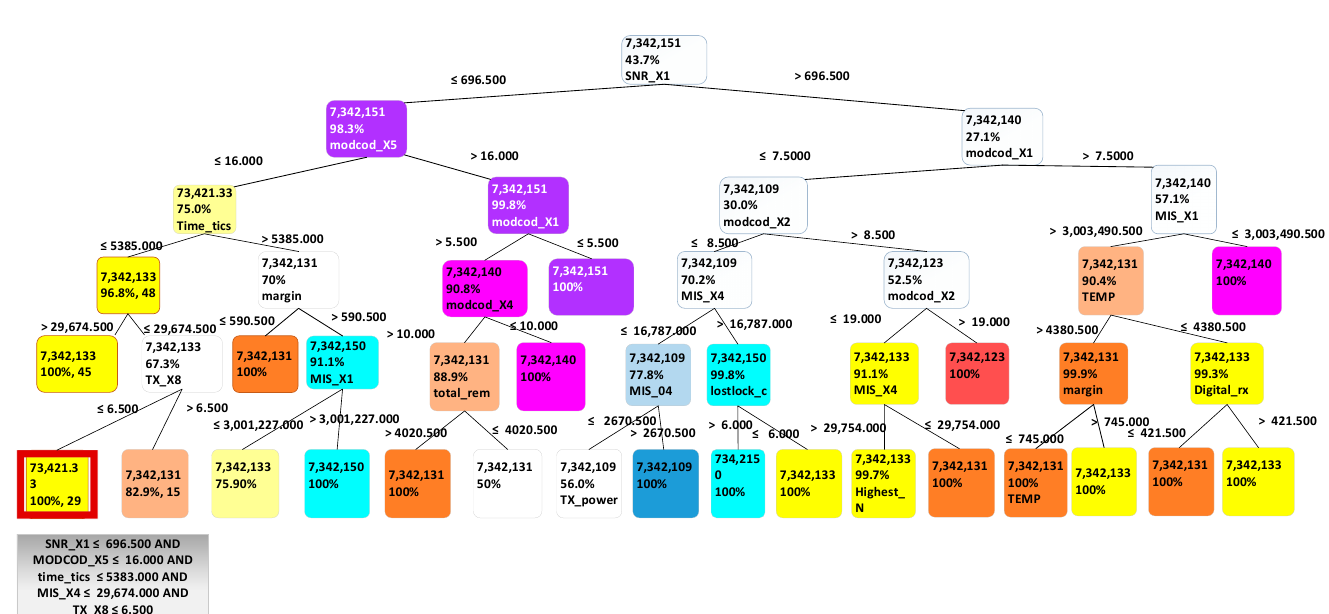
Figure 6. Classification decision tree for all sub route groups for many terminals.